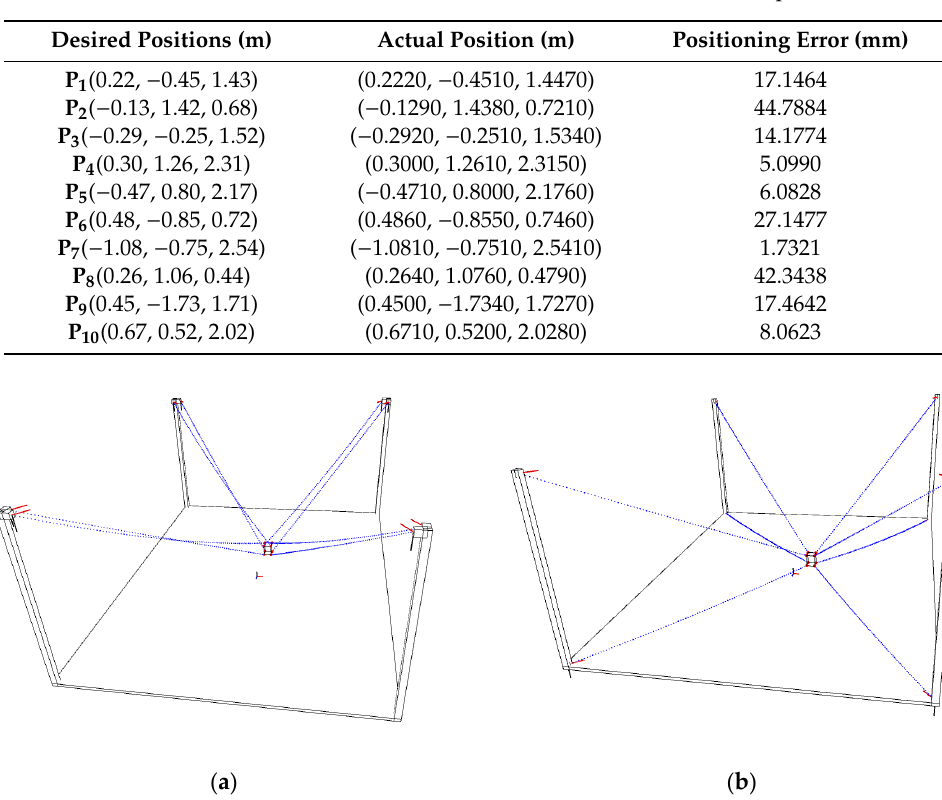
Table 2. Performance of model in our CDPM based on set of static poses.